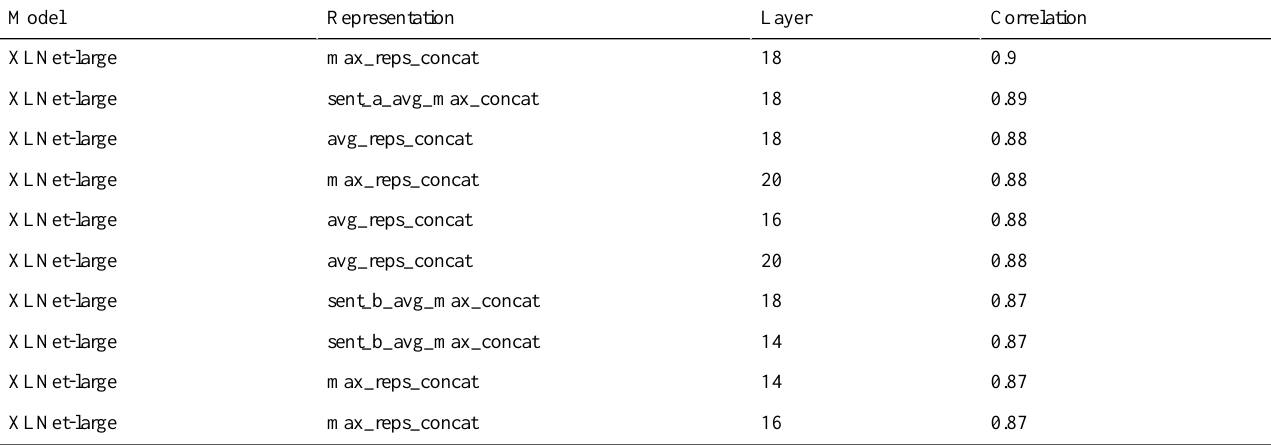
Table 5. The overall top decoding scores ranked in descending order. All the top-performing representations were extracted from XLNet and are mostly made up of the concatenation of the max-/mean-pooled token representations in the 2 sentences that were extracted from middle-late layers.